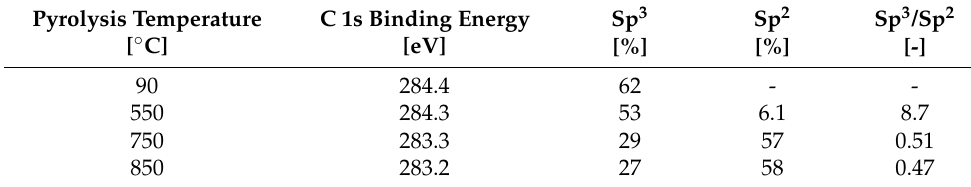
Table 3. C 1s XPS elemental analysis of SiO 2 -ZrO 2 -polybenzoxazine preceramic resin after pyrolysis at different temperatures. Adapted from